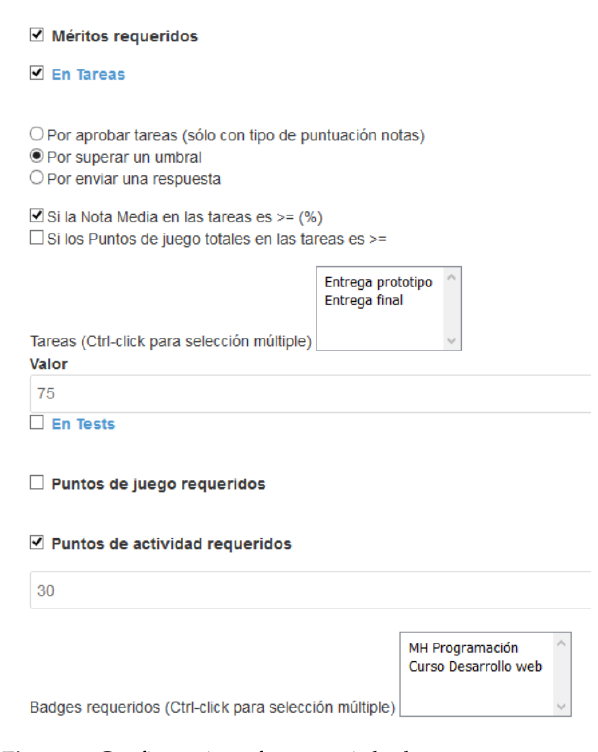
Figure 2. Configuration of automatic badge.